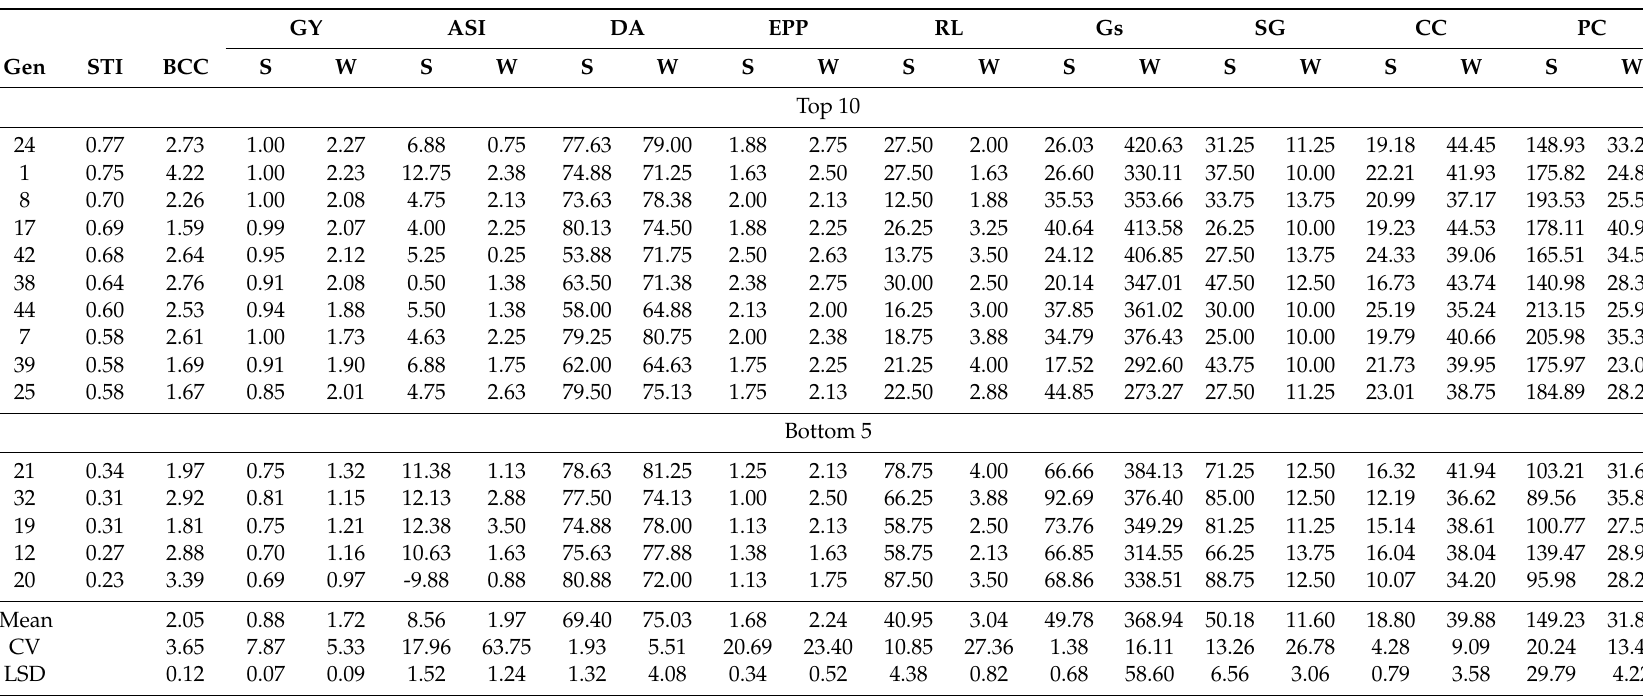
Table 2. Mean performance of the top 15 and bottom 5 provitamin A maize inbred lines with > 1.5 µ g g − 1 BCC and ranked in descending order of STI